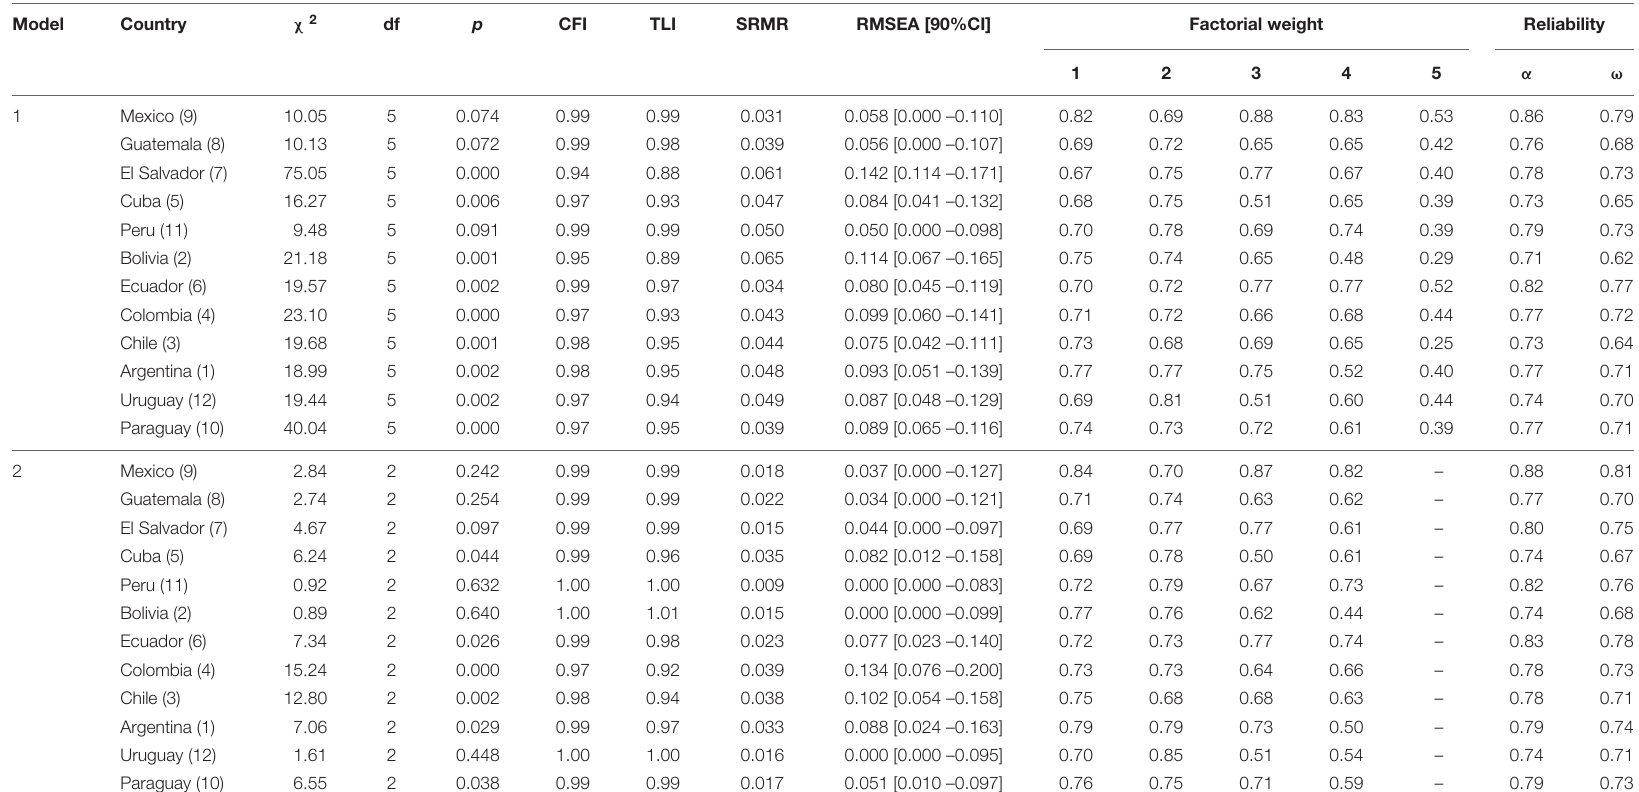
TABLE 4 | Fit indices, factorial weights, and reliability of the unidimensional models in American countries.